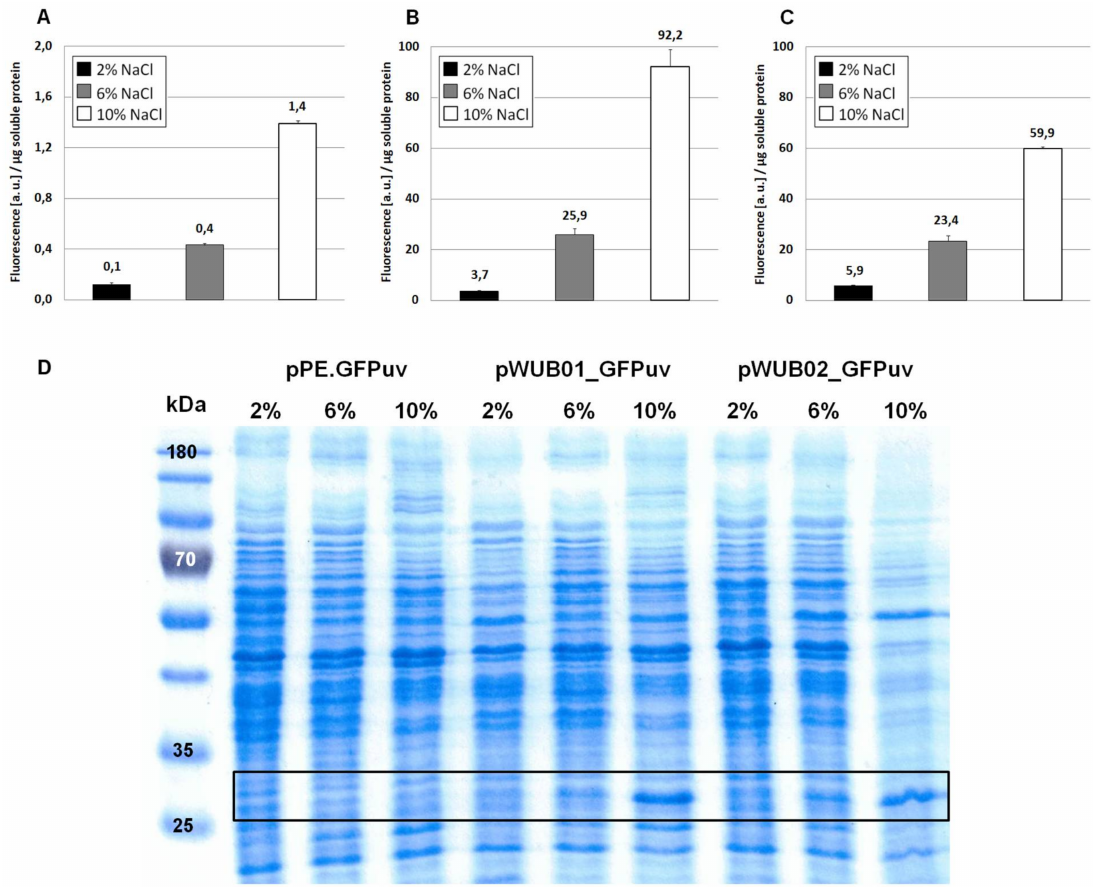
Figure 2. Expression of GFPuv in H. elongata , part I. Strains expressing the reporter protein GFPuv were grown in MM63 medium at constant NaCl concentrations (2%, 6%, or 10% w/v ) until early stationary phase. Then, cultures were harvested and soluble protein fractions were isolated, purified and used for fluorescence measurements and SDS-PAGE. ( A ) H. elongata pPE.GFPuv, ( B ) H. elongata pWUB01_GFPuv, ( C ) H. elongata pWUB02_GFPuv, fluorescence (arbitrary units, a.u.) per µ g soluble protein fraction of H. elongata strains. ( D ) SDS-PAGE of soluble protein fractions of respective H. elongata strains. GFPuv has a size of 26.8 kDa,